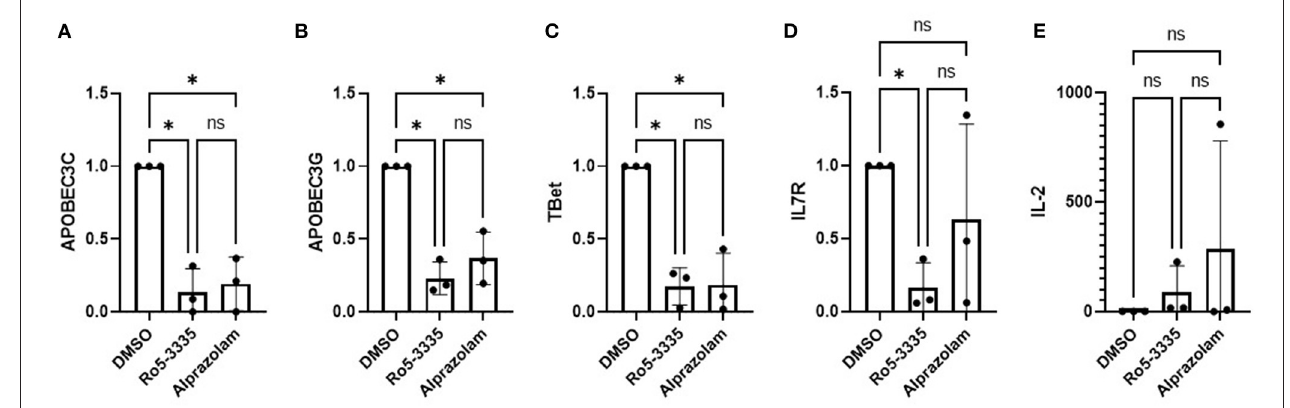
FIGURE 2 | Effect of alprazolam ex vivo on RUNX1 responsive genes. Peripheral blood mononuclear cells (PBMC) from three HIV-1-1 positive individuals were treated with 10 µ M Alprazolam or Ro5-3335 for 48h. RNA was harvested using Trizol and cDNA was synthesized by RT reaction. qPCR was performed for five known RUNX responsive genes: (A) APOBEC3C, (B) APOBEC3G, (C) Tbet, (D) IL-7R and (E) IL-2. Expression levels are plotted as GAPDH normalized expression with the levels in the control for each individual. Dots represent each individual data point and graphs show the average. ANOVA was used to determine statistical differences. * p < 0.05.